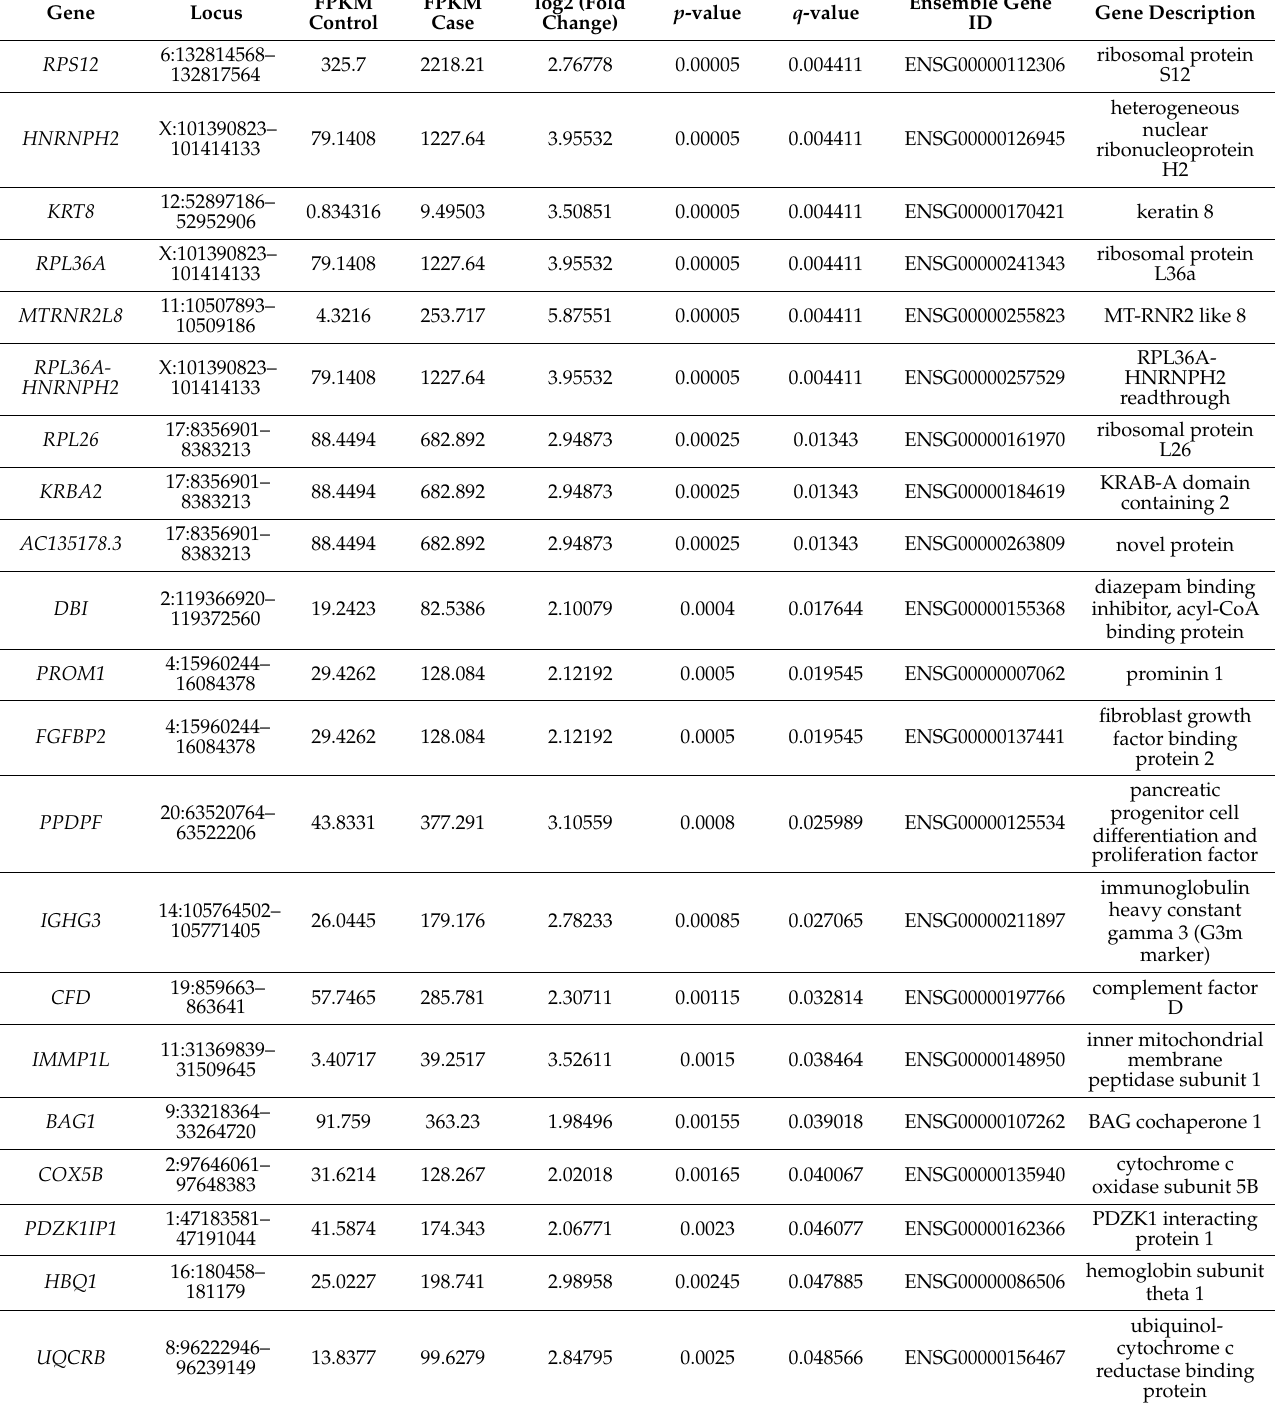
Table 3. List of the top 20 upregulated genes with fold changes ≥ 1.98, p -values ≤ 0.0025 and q -values ≤